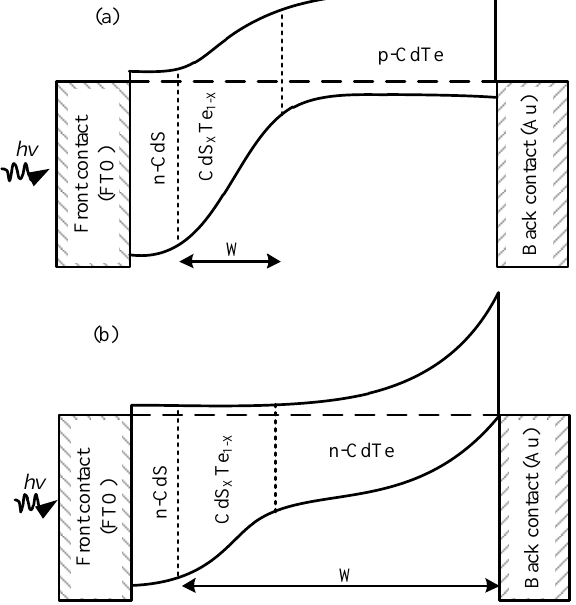
Figure 6. Energy band diagrams representing ( a ) glass/FTO/n-CdS/p-CdTe/Au and ( b ) glass/FTO/ n-CdS/n-CdTe/Au device configurations.